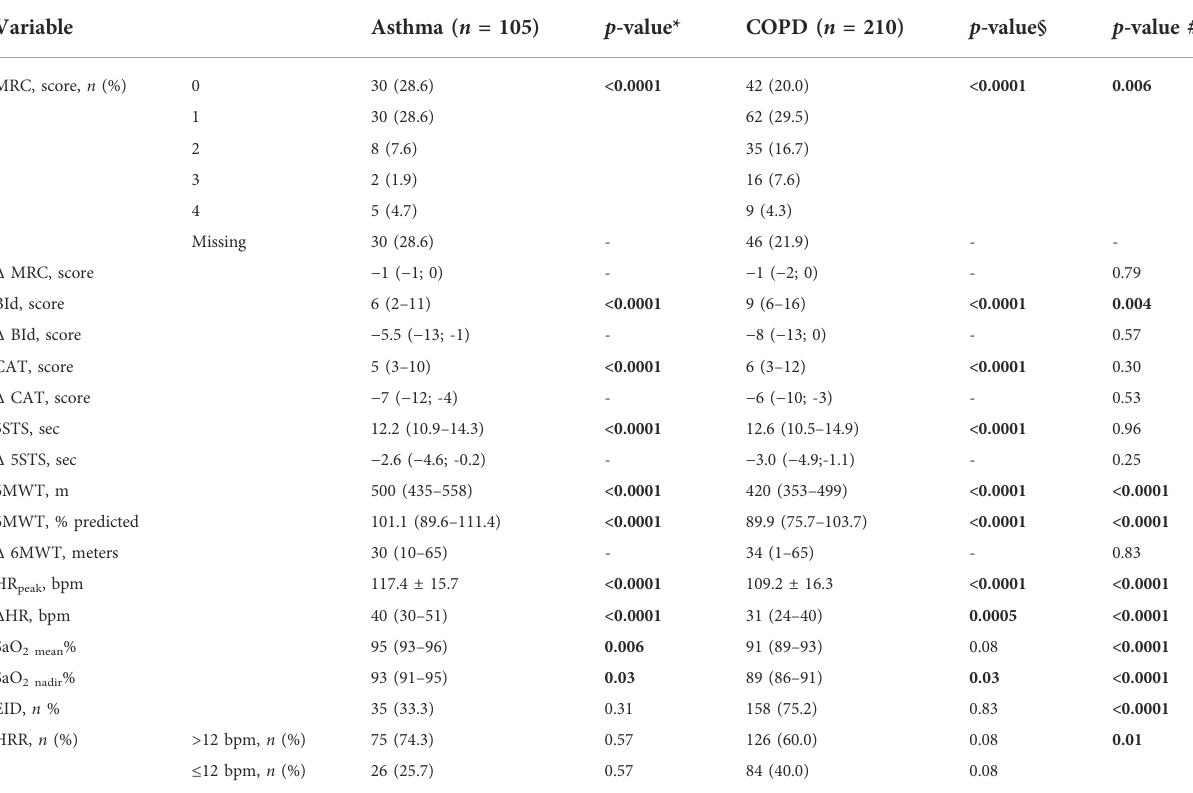
TABLE 3 Post-pulmonary rehabilitation values of and changes in outcome